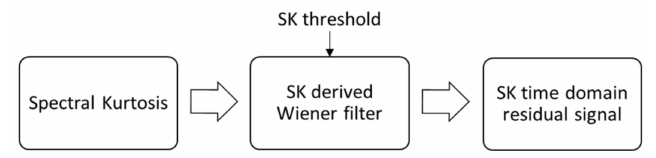
Figure 11. Flowchart: from the Spectral Kurtosis to the SK